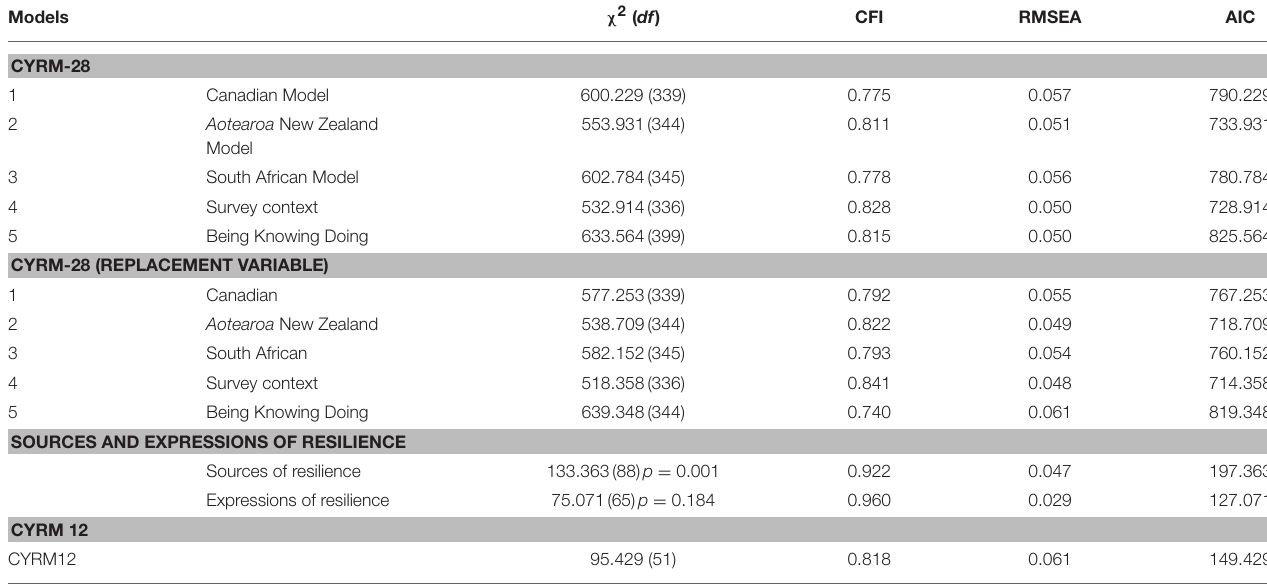
TABLE 4 | Goodness-of-fit for CYRM-28, CYRM-28 with replacement variable, and CYRM-12.